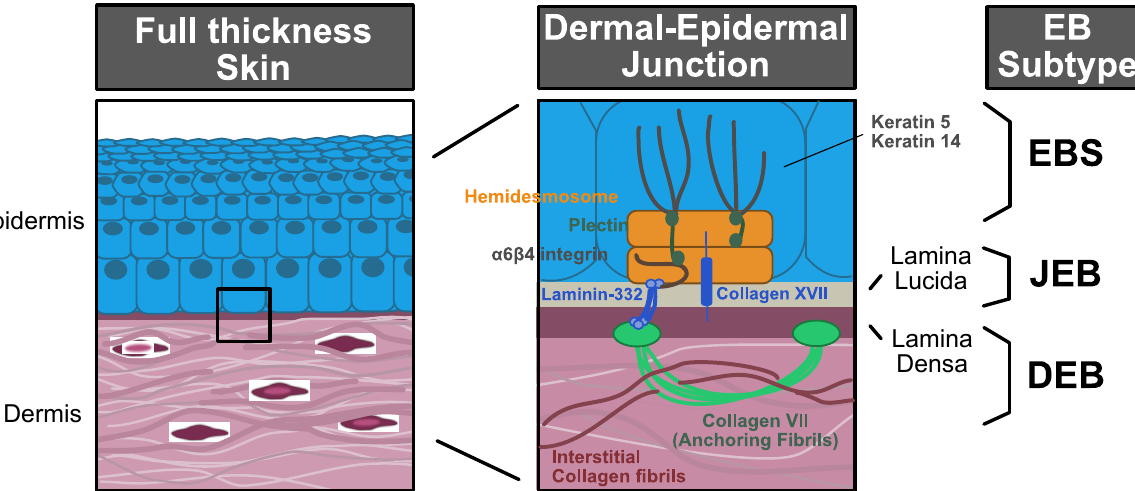
Figure 1. EB subtype schematic.